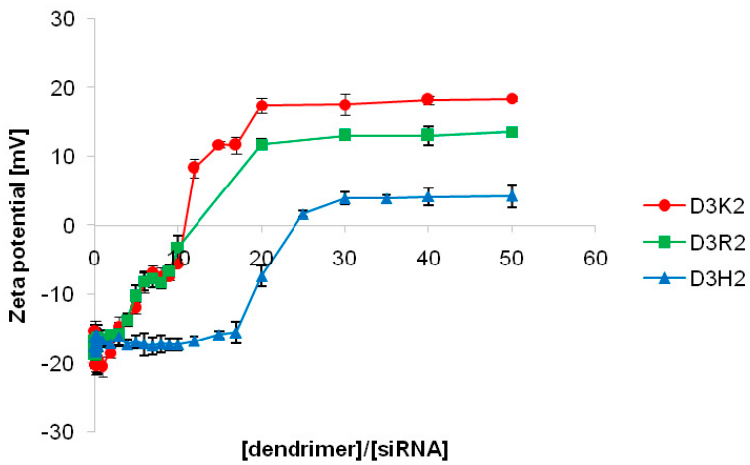
Figure 3. Changes in the zeta potential as a function of the dendrimer:siRNA molar ratio (average ± SD, n = 3).